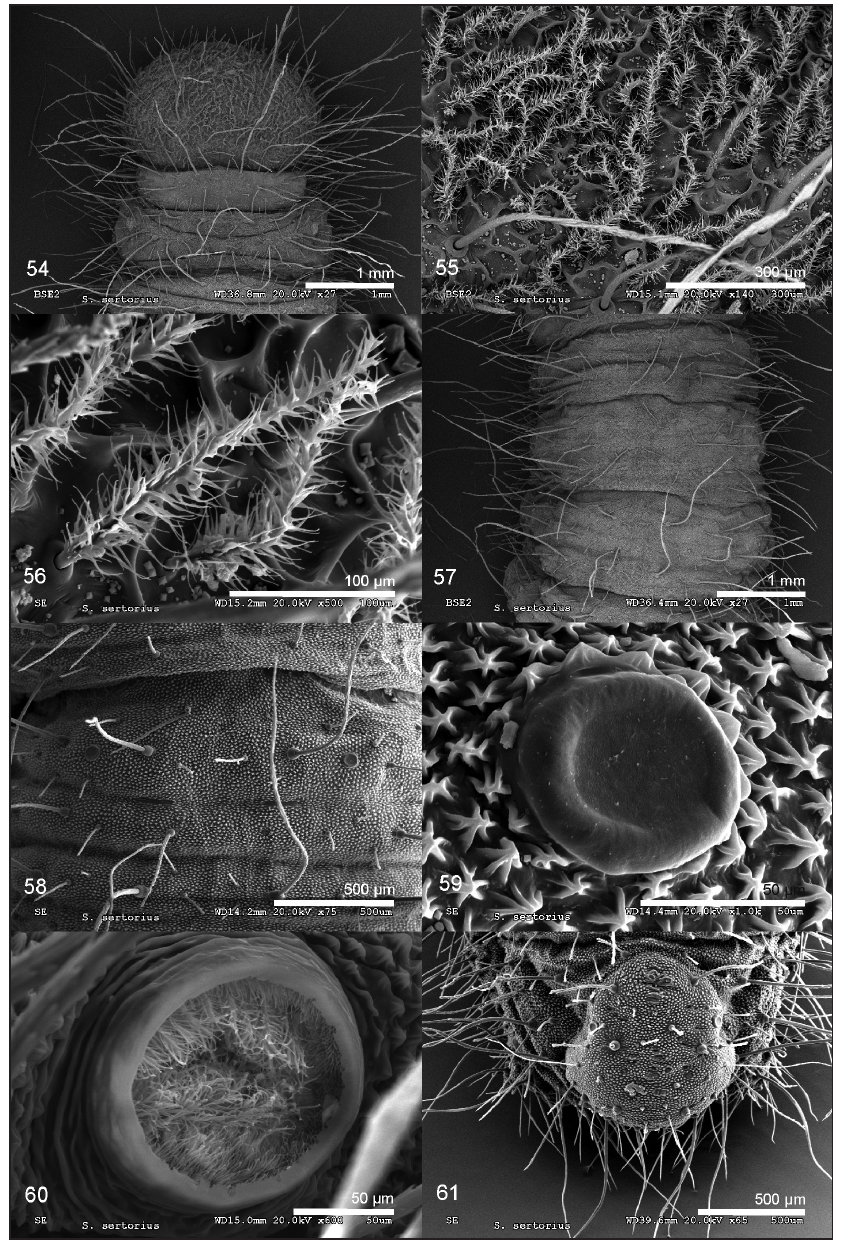
Figures 54–61. Scanning electron microscope images of a last instar larva of Spialia sertorius from Losar de la Vera, Cáceres, Central Spain. 54 . Head capsule and collar. 55, 56. Detail of the head capsule setae and sculpture. 57. Cuticular formations on thoracic and abdominal segments. 58. Detail with different types of subdorsal and lateral setae on the first thoracic segment: long and short setae with pointed tips. 59. Detail of a barrel-like formation and the cuticular sculpture. 60 Last abdominal spiracle. 61. Last abdominal segments with the anal plate and setae with pointed tips and rounded